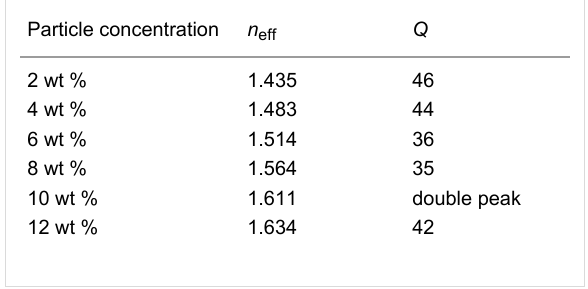
Table 1: n eff and Q -factor values with respect to the concentration of TiO 2 nanoparticles in the spincoat solution. n eff is calculated with Equation 2 and Q is calculated with Equation